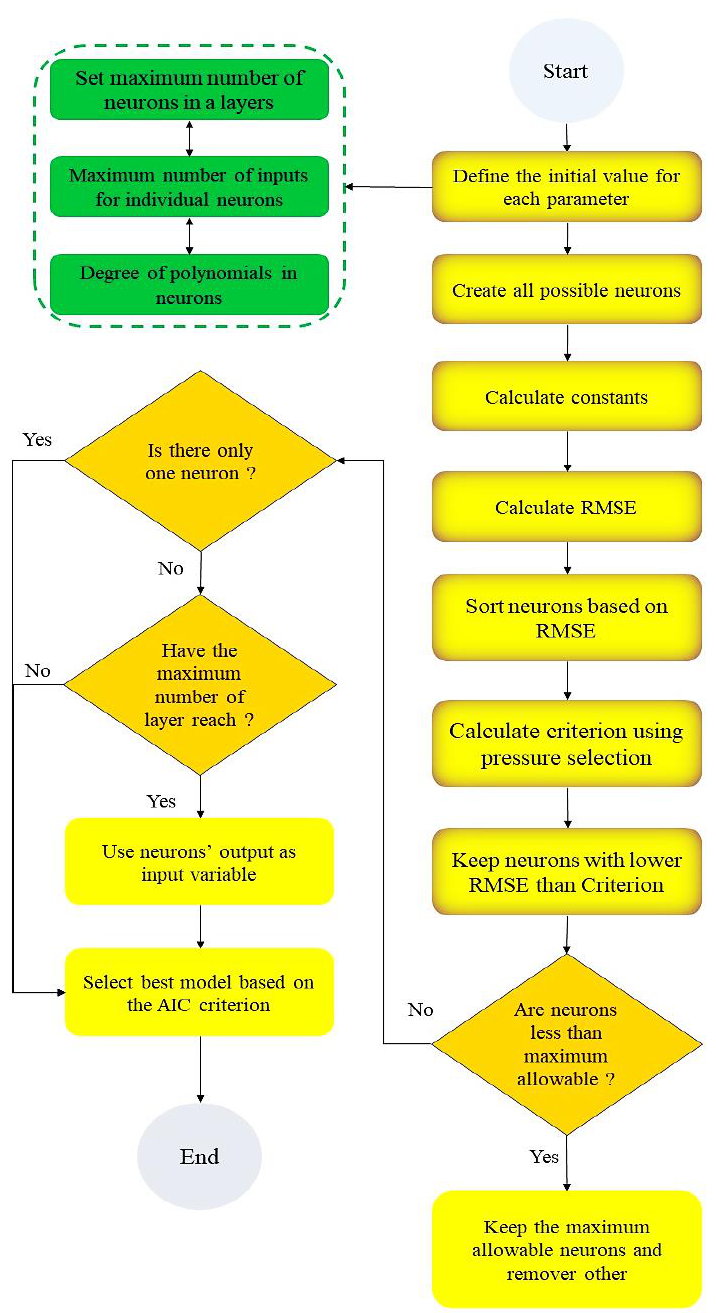
Figure 1. The flowchart of the proposed GSGMDH.